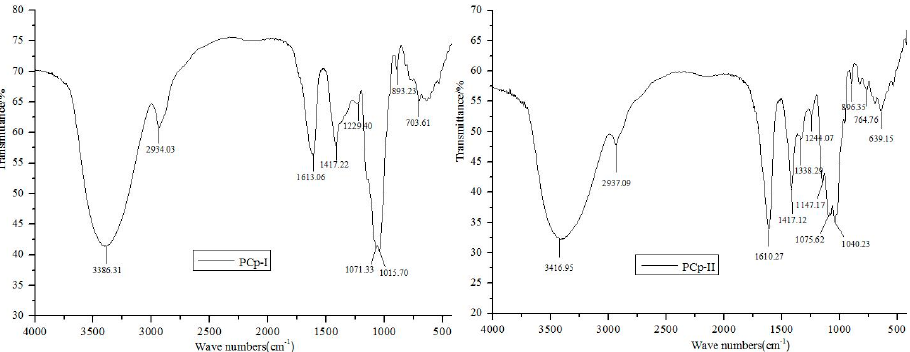
Figure 4. Fourier transform-infrared spectroscopy (FT-IR) spectra of PCp-I and PCp-II.